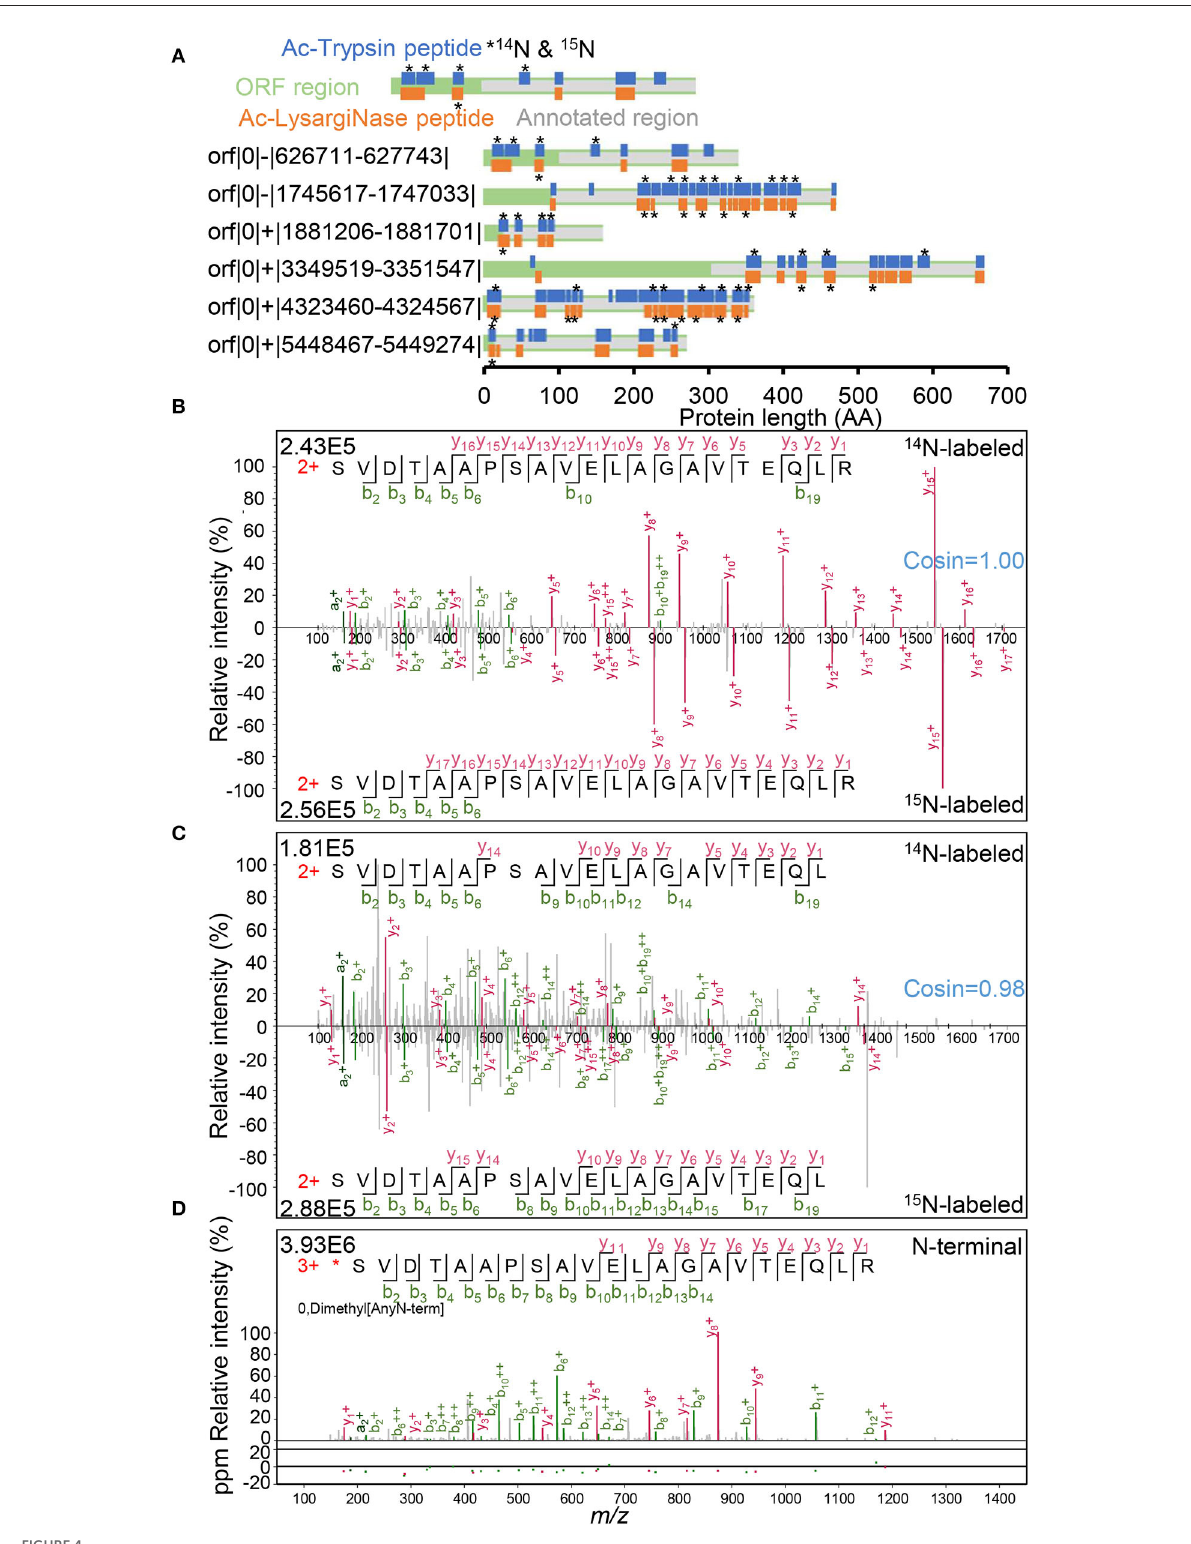
FIGURE4 N-termini correction of 6 annotated proteins. (A) Novel peptides distribution in N-terminal extension regions. Peptide labeled star stands for 14 N and 15 N labeling spectra identification. The confirmed spectra of N-terminal peptides with 14 N and 15 N labeling forms were derived from the Ac-Trypsin (B) and Ac-LysargiNase (C) datasets, respectively. (D) The spectra of an N-termini labeled peptide with dimethyl modification from our N-terminomic